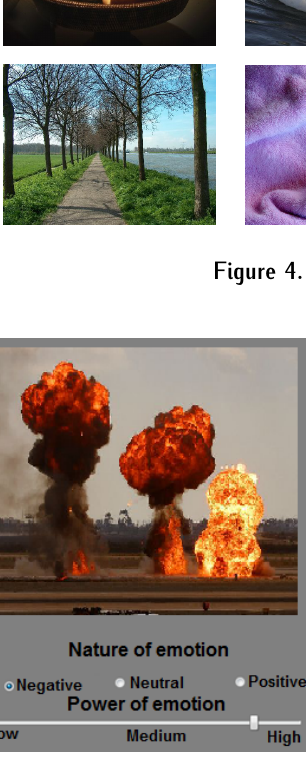
Figure 5. Emotional evaluation of SENSE